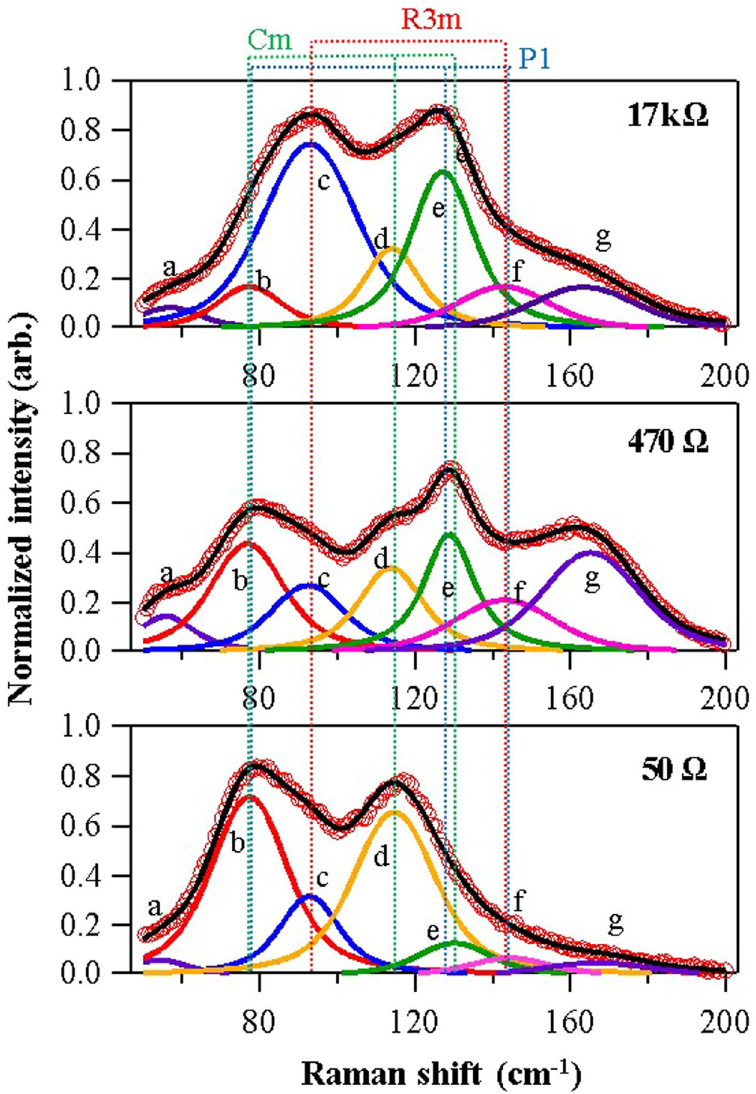
Figure 7. Raman spectra of annealed and laser-irradiated GeTe thin films. Each spectrum can be deconvoluted into seven peaks. Each peak is identified by means of DFT calculations and references. The change in Raman intensity for laser-irradiated samples corresponds to the structural transformations observed in the XRD results.